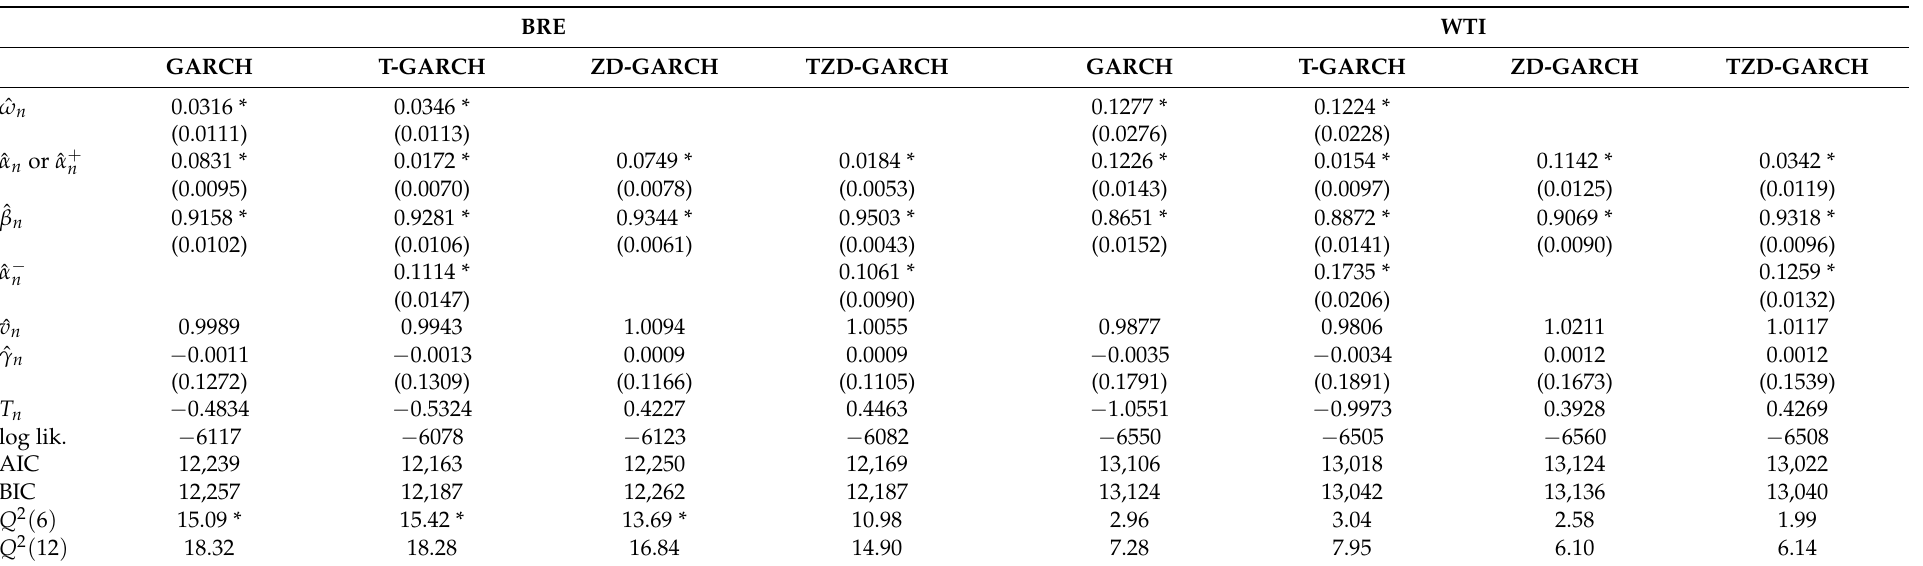
Table 7. Empirical results: BRE and WTI